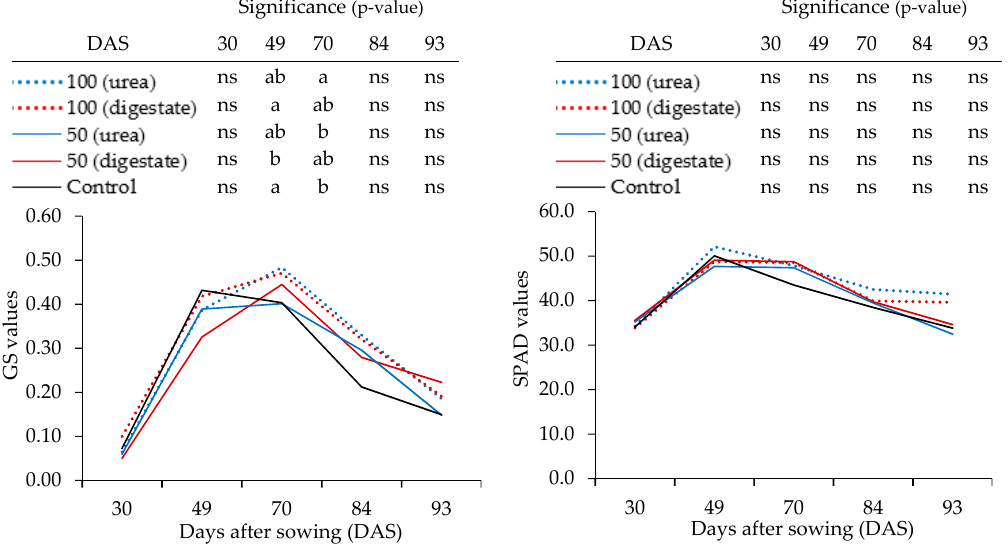
Figure 3. Time series of GreenSeeker-GS (left) and SPAD-502 readings (right) for different N fertilization treatments (100 / 50 kg N ha − 1 urea, 100 / 50 kg N ha − 1 digestate, and 0 kg N ha − 1